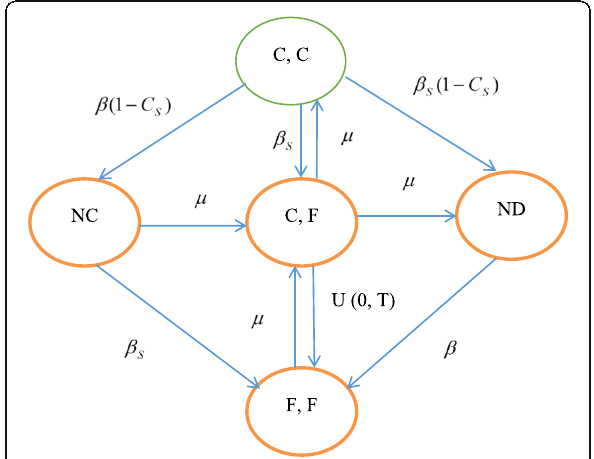
Fig. 2 Semi-Markov chain-based State Transition Diagram of